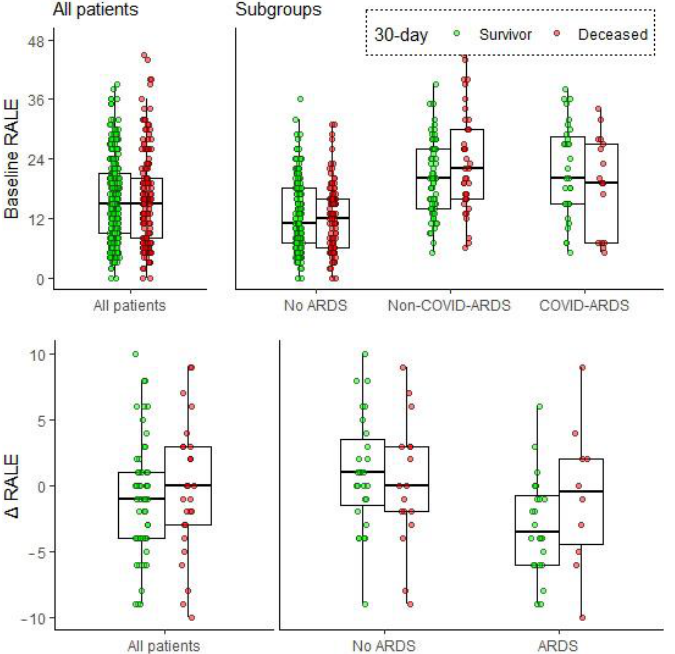
Figure 3. Baseline RALE scores and ∆ RALE. Data are stratified and coloured by 30-day mortality in the entire study cohort and in predefined ARDS subgroups (no ARDS, non-COVID-ARDS, COVID-ARDS). As there were only 5 COVID-ARDS patients with an additional day 1 CXR available, COVID-ARDS and non-COVID-ARDS were combined into ARDS when looking at ∆ RALE. Individual patient data points are plotted as dots. RALE = Radiographic Assessment of Lung Edema; ARDS = Acute Respiratory Distress Syndrome; ∆ RALE = Early change in RALE score (RALE day 1 — RALE baseline); COVID = Coronavirus disease 2019. Table 2. Baseline RALE scores and 30-day mortality.